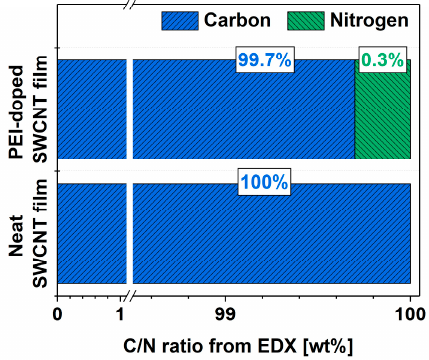
Figure 5. Composition of the SWCNT films before and after doping determined from EDX as C/N atomic ratio.